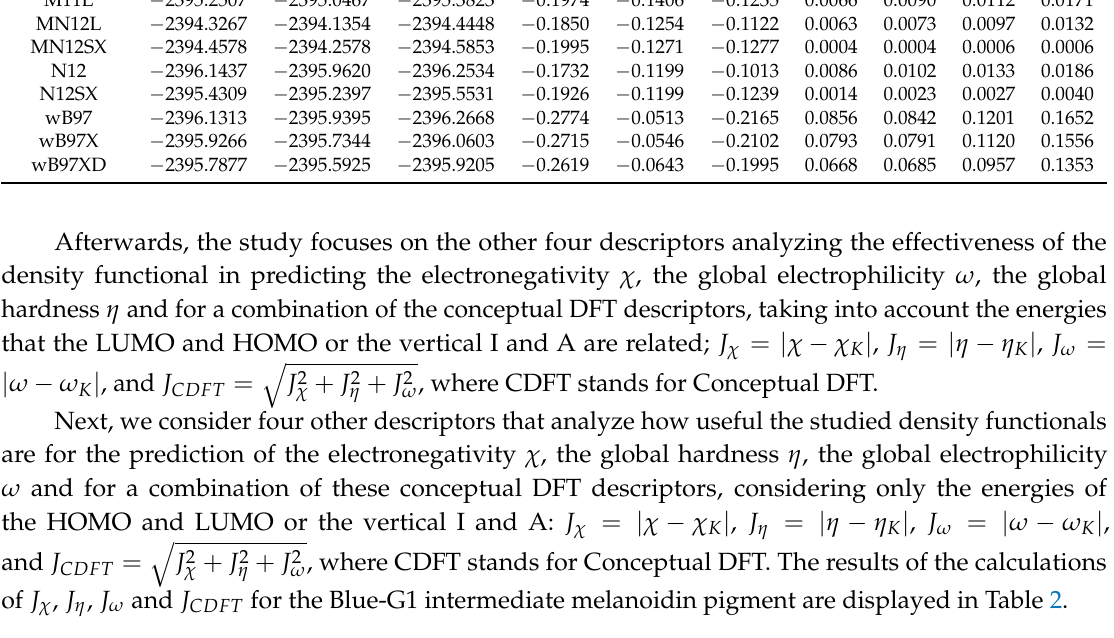
Table 2. J χ , J η , J ω and J CDFT for the Blue-G1 intermediate melanoidin